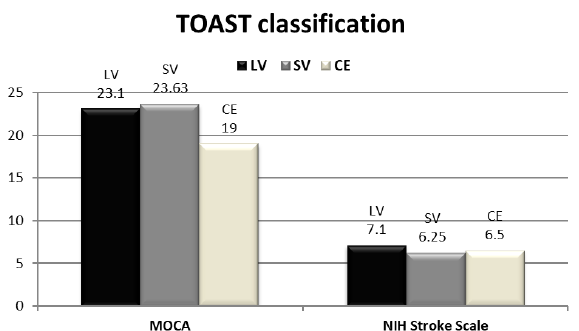
Figure 2. Relationship between Trial of ORG 10172 in Acute Stroke Treatment classification (atiology) and both Montreal Cognitive Assessment scale and National Institute Health Stroke Scale.